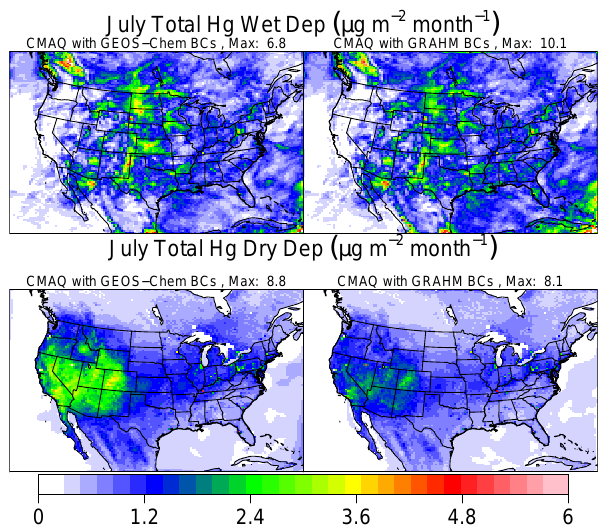
Fig. 7. Simulated mercury deposition from CMAQ runs using boundary conditions derived from a GEOS-Chem simulation with the upper layer mercury concentrations zeroed out using 2001 and 2005